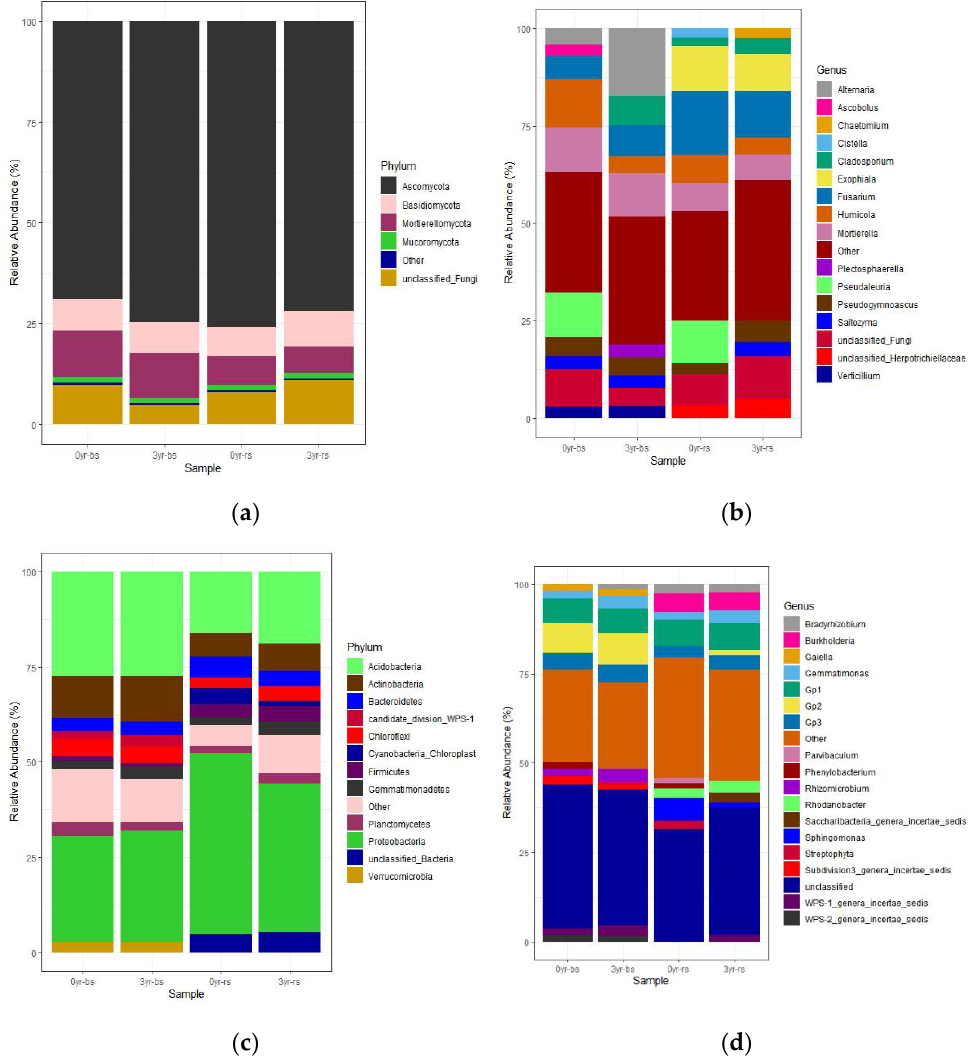
Figure 5. The relative abundance of the main fungal and bacterial groups present in the American ginseng rhizosphere when grown in soils with different monoculture history, at the phylum level and the genus level: ( a , b ) are fungi, ( c , d ) are bacteria. Only the top ten phyla and genera in relative abundance are displayed. 0 yr-bs: bulk soil with no American ginseng growing history; 3 yr-bs: bulk soil with 3-year monoculture; 0 yr-rs: rhizosphere in the soil with no American ginseng growing history; 3 yr-rs: rhizosphere in the soil with 3-year monoculture.